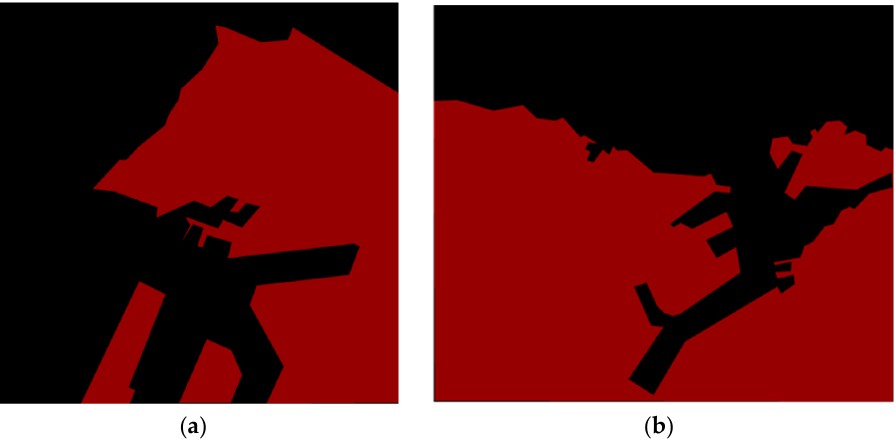
Figure 10. Labeling results of testing data: ( a ) Taichung Port; ( b ) Keelung Port.